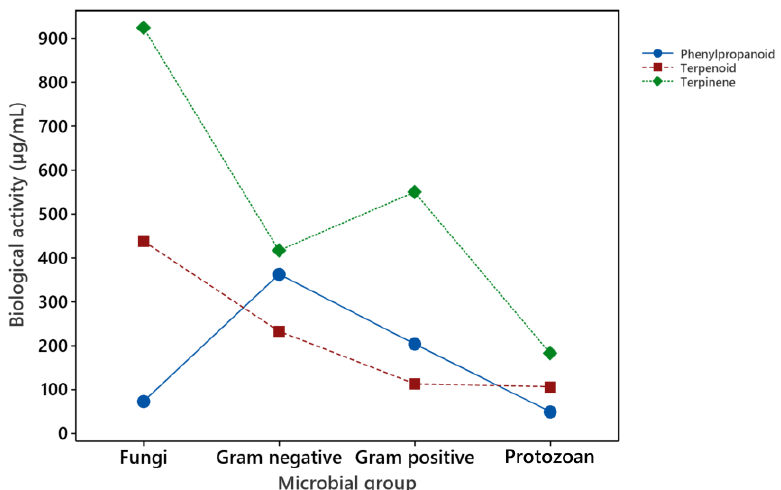
Figure 3. Interaction on the antimicrobial activity of major components of essential oils and bacteria, fungi, and protozoans. The chemical components were grouped according to their chemical structure in phenylpropanoids (cinnamaldehyde, eugenol, anethole), terpenoids (carvacrol, cuminaldehyde, eucalyptol, thymol) and terpinenes (limonene). The biological activity for Gram-positive bacteria ( B. cereus , S. aureus , L. monocytogenes ), Gram-negative bacteria ( E. coli , S. typhimurium , S. sonnei ), and molds ( A. niger , A. ochraceus , A. alternata , F. oxysporium ) was CMI. IC50 was used for T. cruzi and L. mexicana , and LD50 was used for G. lamblia . The points are the average of the measures for terpinenes (n = 12 for fungi, n = 9 for bacteria and protozoans), terpenoids (n = 48 for fungi, n = 36 for bacteria and protozoans), and phenylpropanoids (n = 36 for fungi, n = 27 for bacteria and protozoans).